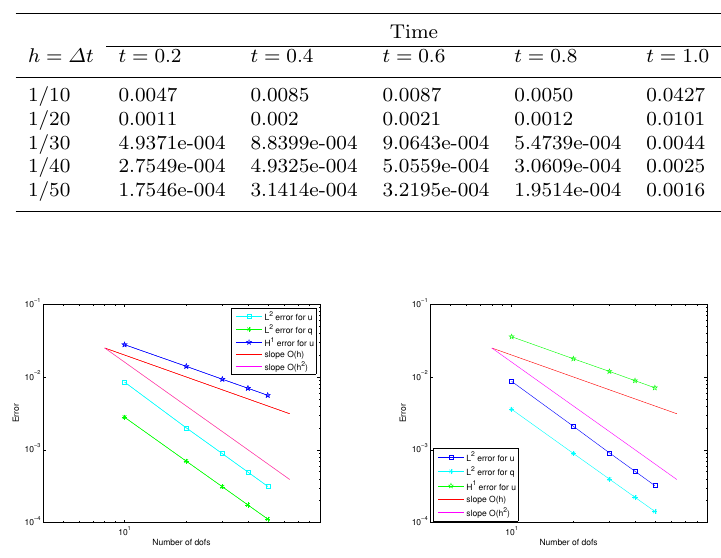
Table 3. The errors of (cid:107) q n − Q n